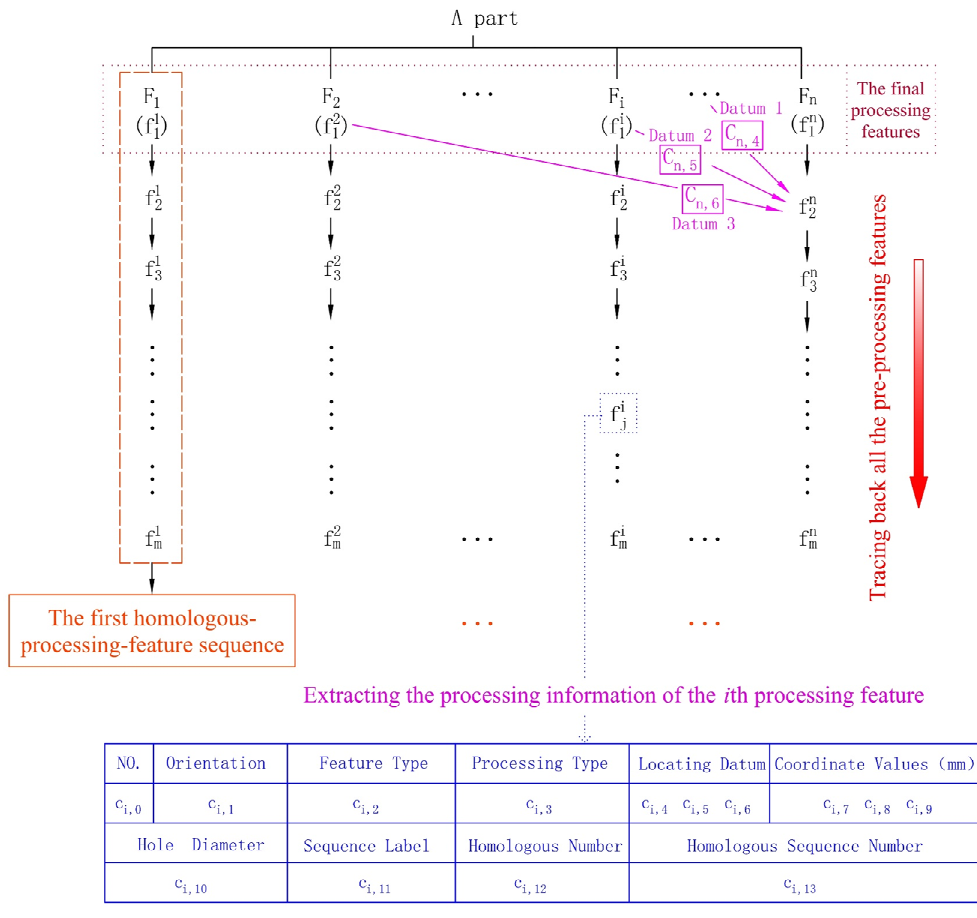
Figure 5. An example of extracting the processing information of a part: ( a ) Obtain all of the final processing features of the part; ( b ) obtain a homologous processing feature sequence by tracing back from a final processing feature; ( c ) extract the processing information of processing feature 𝑓 (cid:2870)(cid:2871) .